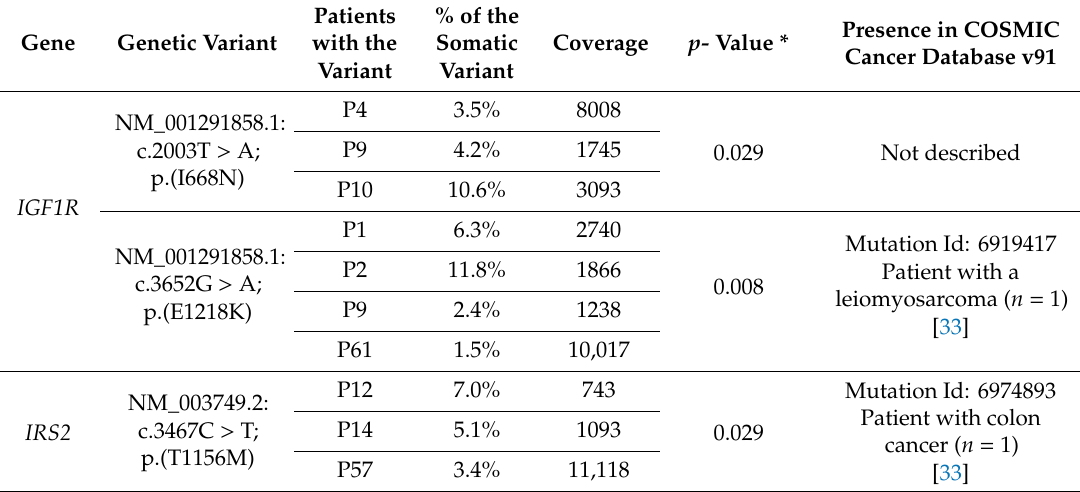
Table 4. Genetic variations significantly associated with lack of response to anti-EGFR